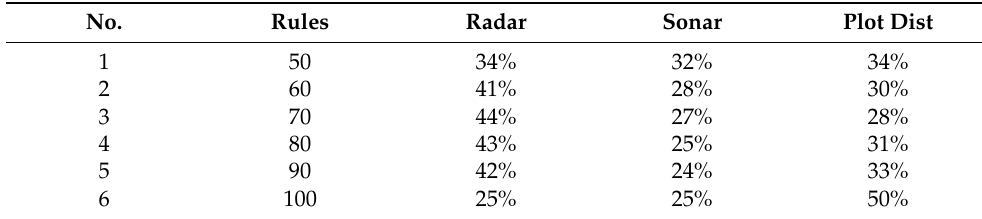
Table 2. Scenarios according to the number and type of rules.